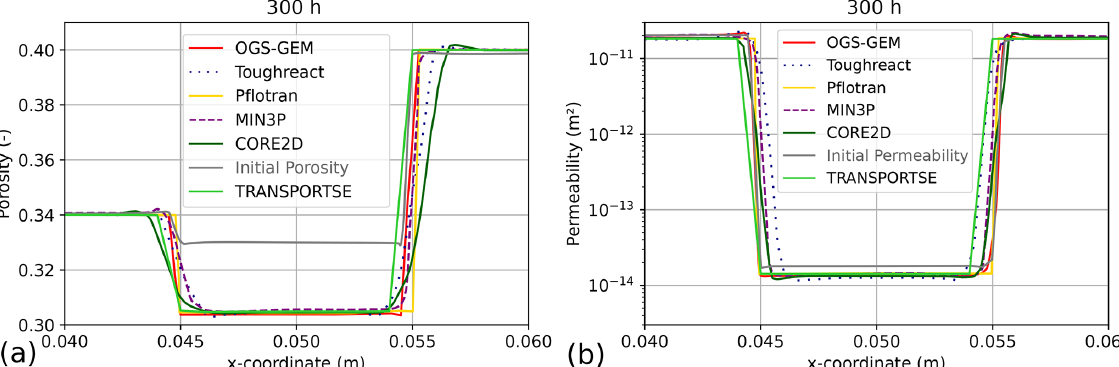
Figure 10. Calculated (a) porosity and (b) permeability changes along Line 1 at a simulation time of 300h calculated by TRANSPORTSE- PHREEQC in comparison against the results documented by Poonoosamy et al.